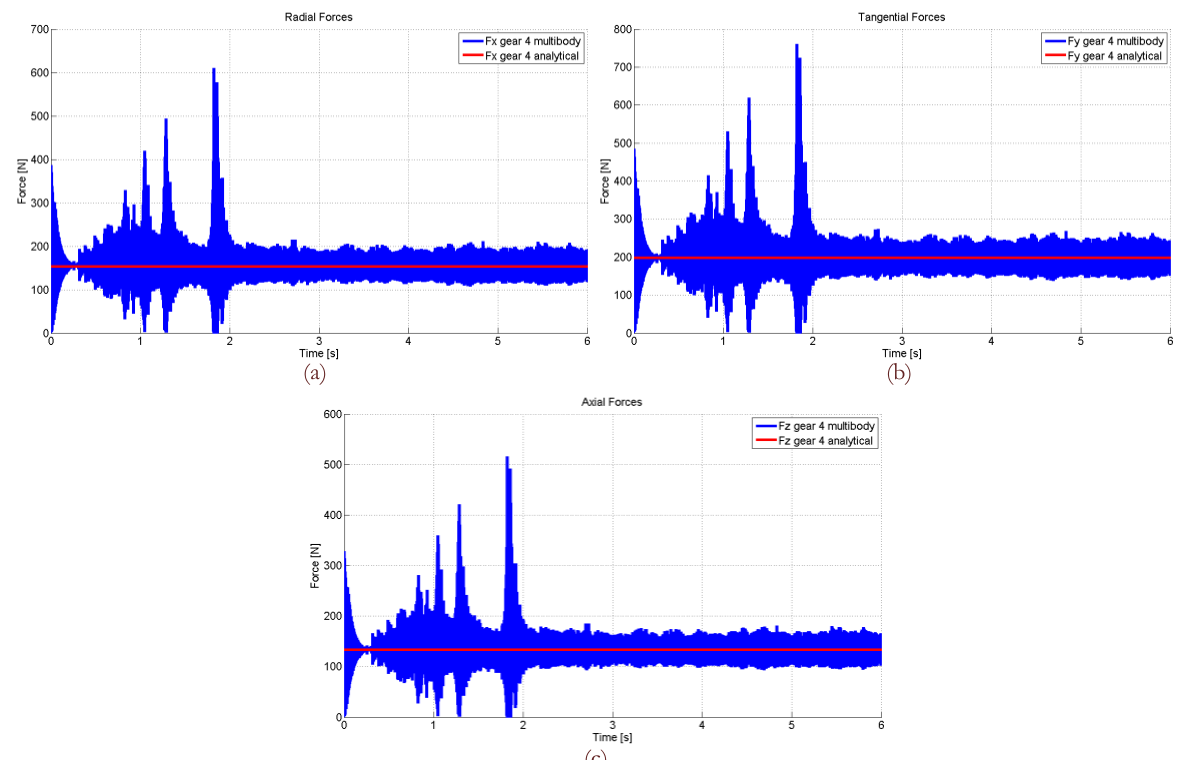
Figure 3: Forces of the Rigid simulation of Gear 4, (a) contact force in x direction (radial force), (b) contact force in y direction (tangential force), (c) contact force in z direction (axial